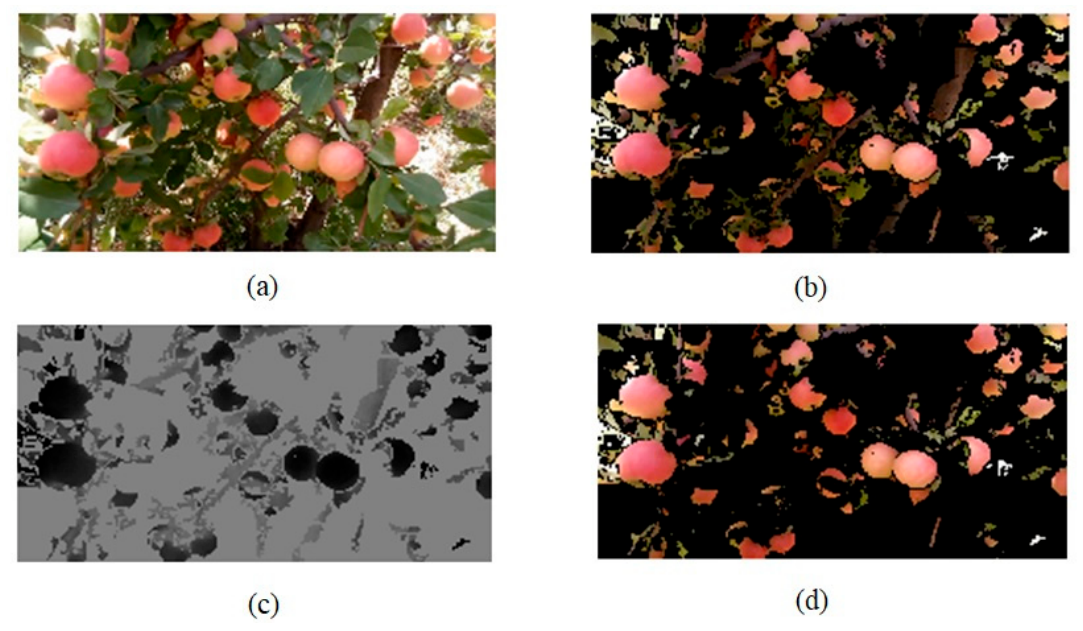
Figure 4. Intensity transformation performance in the third step of segmentation. ( a ): Original image, ( b ): Image segmented before this step, ( c ): Image corresponding to intensity transformation, ( d ): Image segmented after applying the threshold on the image of the intensity transformation.